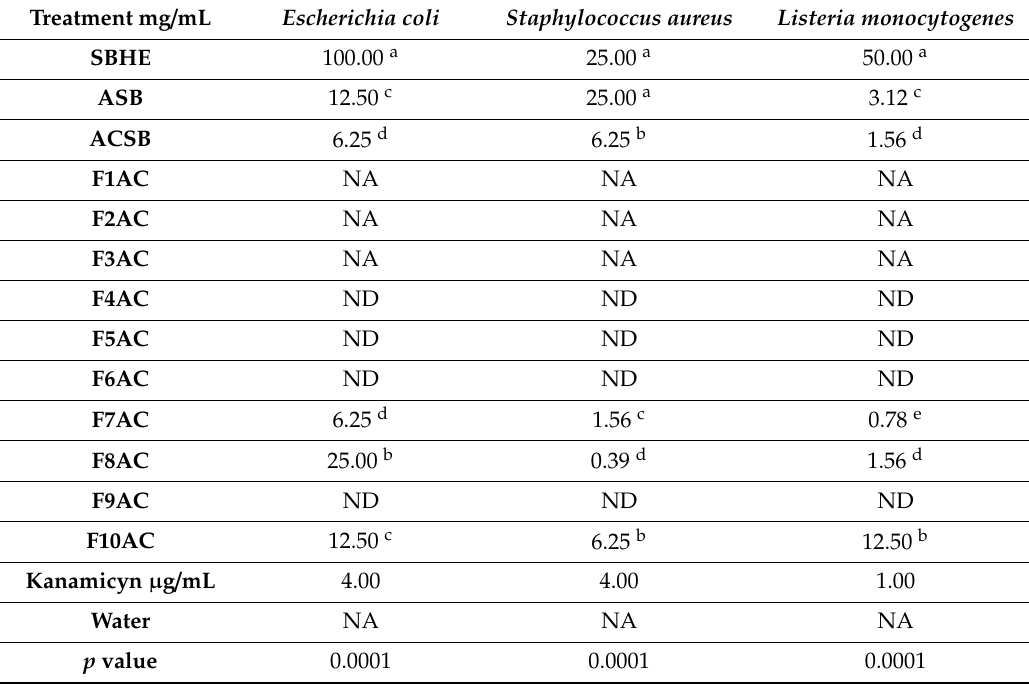
Table 1. Minimal Inhibitory Concentration of the Salix babylonica hydroalcoholic extract and fractions against Escherichia coli, Staphylococcus aureus , and Listeria monocytogenes. Treatment mg /